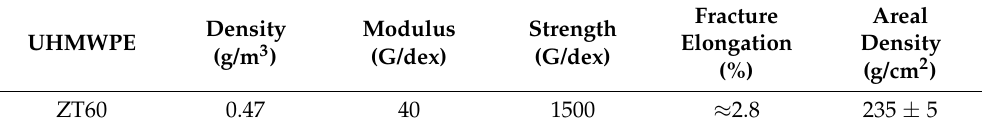
Table 2. Physical properties of PE backplane material.